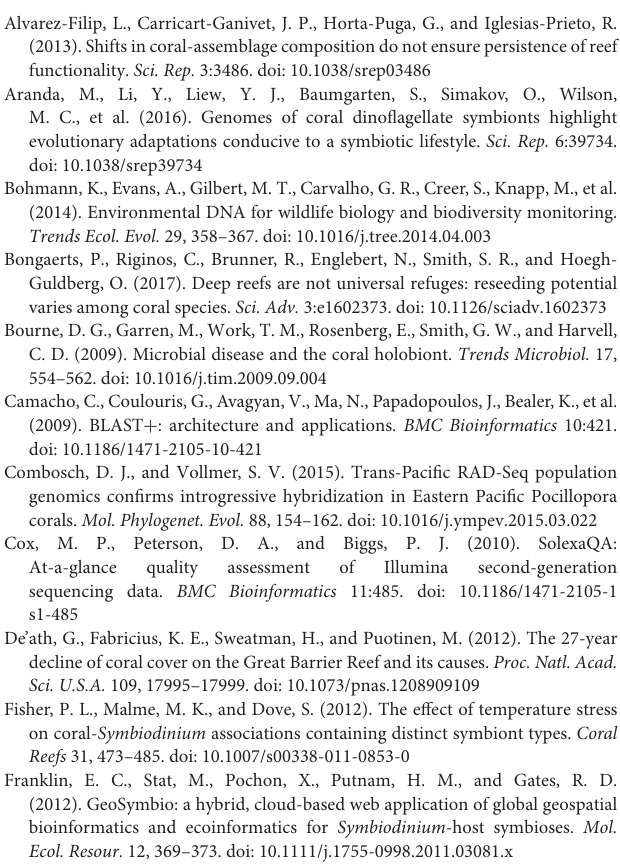
Figure S2 | Rate of identical nucleotides in 60-bp sliding window of aligned mitochondrial genomes of Acropora corals used in this study. mtCR and RNS2 and GR primer flanking sequences are shown.